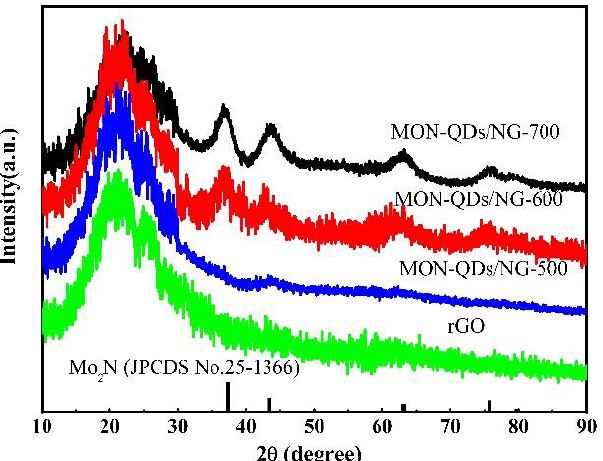
Figure 1. XRD pattern of MON-QD/NG, rGO and the standard card of face-centered cubic Mo 2 N.